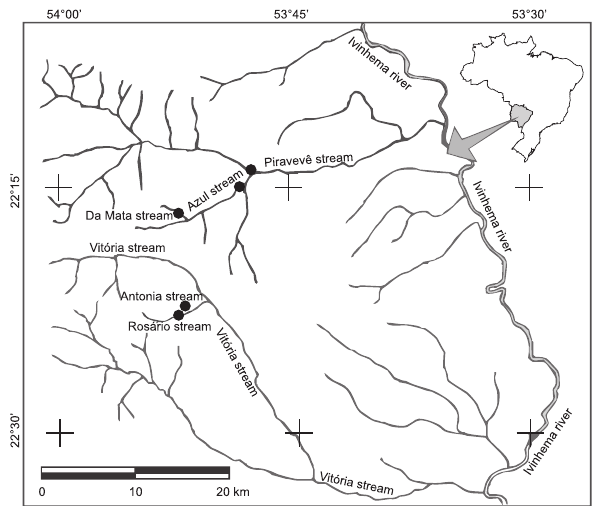
Figure 1. Streams sampled in the Vitória and Piravevê sub-basins of the Ivinhema River Basin, Upper Paraná River, Mato Grosso do Sul,